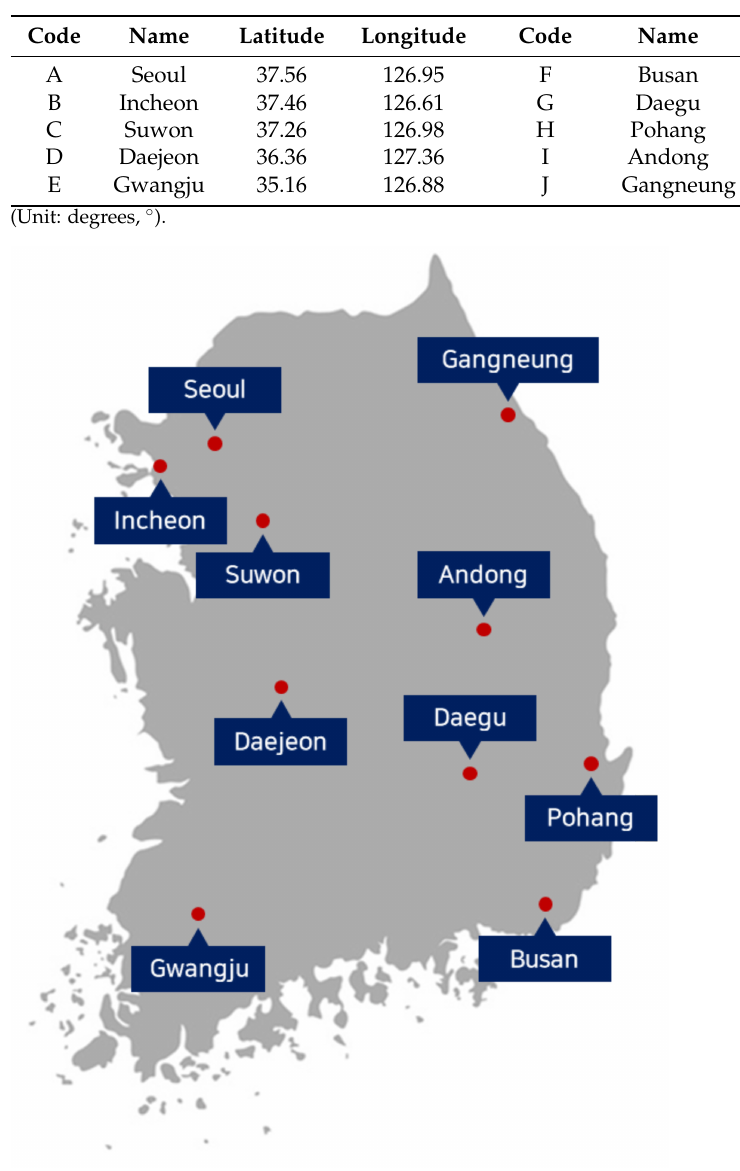
Table 3. Latitudes and longitudes of target regions.